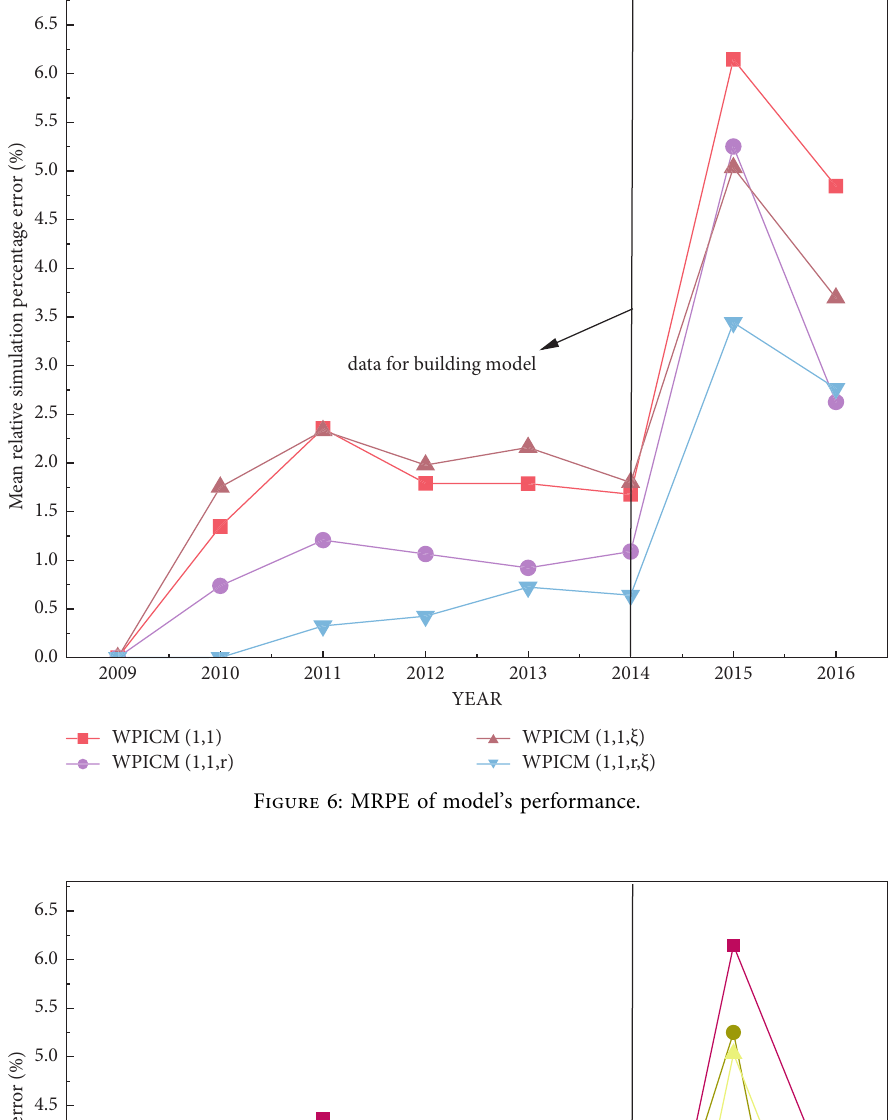
Figure 6: MRPE of model’s performance.